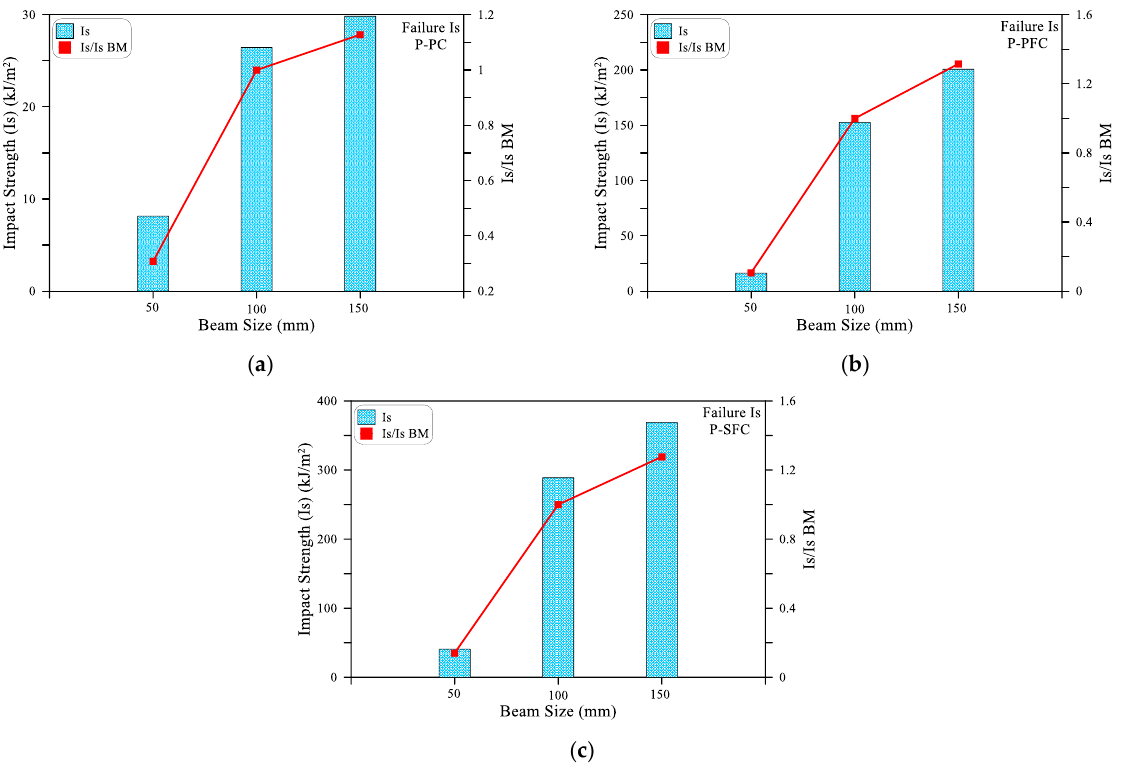
Figure 13. Failure impact strength of the three beam sizes: ( a ) PC; ( b ) P-PFC; ( c ) P-SFC.